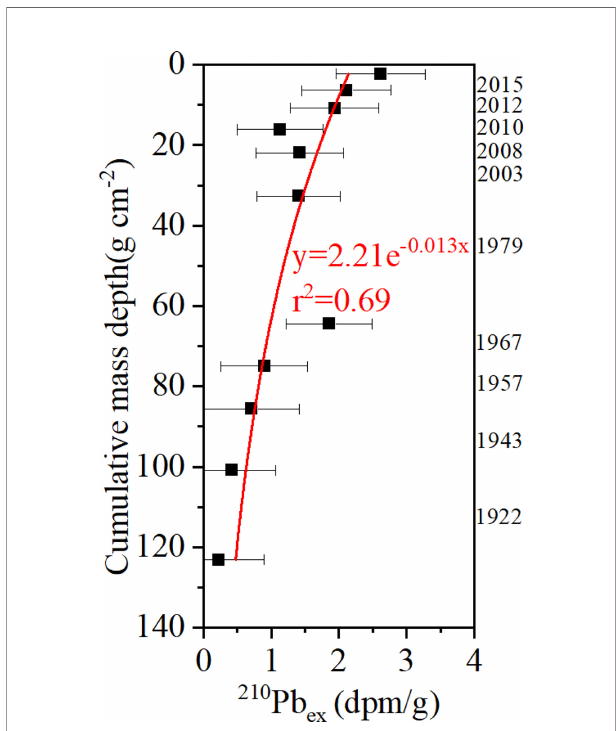
FIGURE 2 | The cumulative mass depth pro fi le of excess 210 Pb ( 210 Pb ex ) of the sediment core. The right scale labeled the -226.84 ‰ (n=6), -399.04 ‰ (n=3), and -316.88 ‰ (n=9) ( Figure S1 ) in stage of 1893 to 1957, 1957 to 1980, and after 1980, respectively. Correspondingly, the average Fm in stages of 1893 to 1957, 1957 to 1980, and after 1980 were 0.78 (n=6), 0.61 (n=3), and 0.69 (n=9) ( Figure S1 ), respectively.